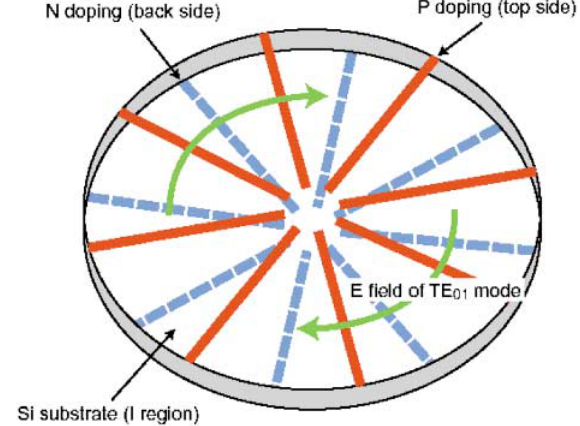
FIG. 9. (Color) Conceptual view of p - i - n (cid:1) n - i - p diode active window.